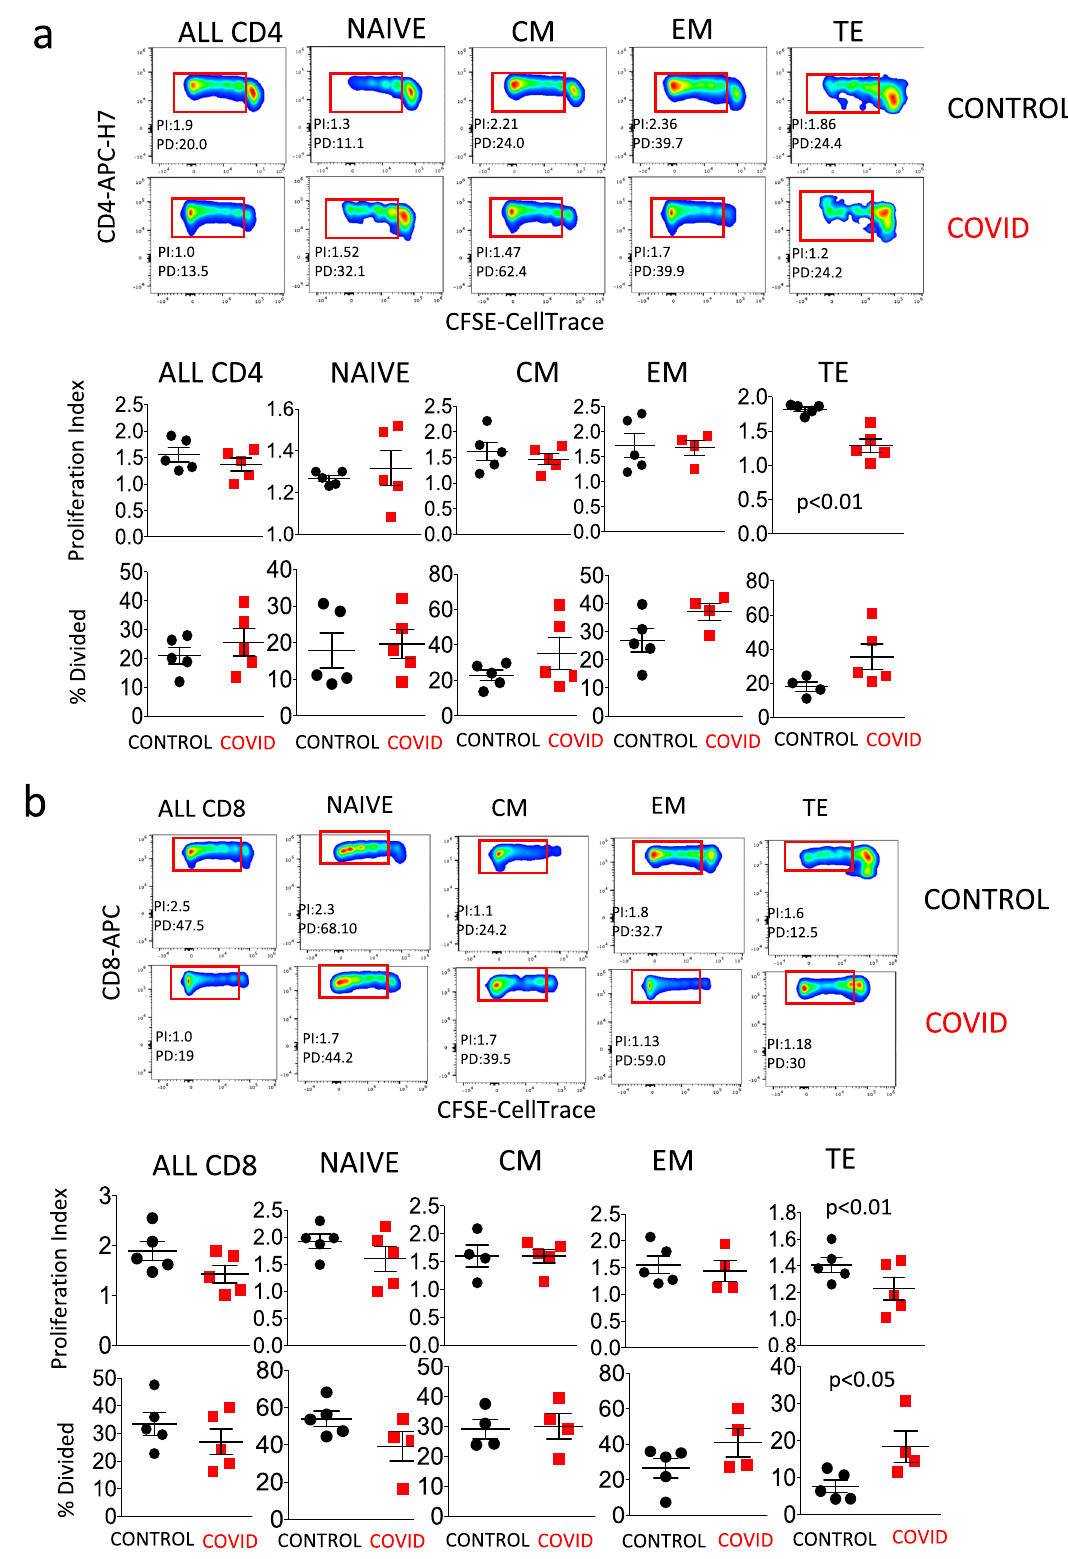
Patients with COVID-19 had increased amounts of CD8 + T cells expressing CD57, which is considered a key marker of in vitro replicative senescence and is associated either to human aging or prolonged chronic infections 33 . CD57 has been used